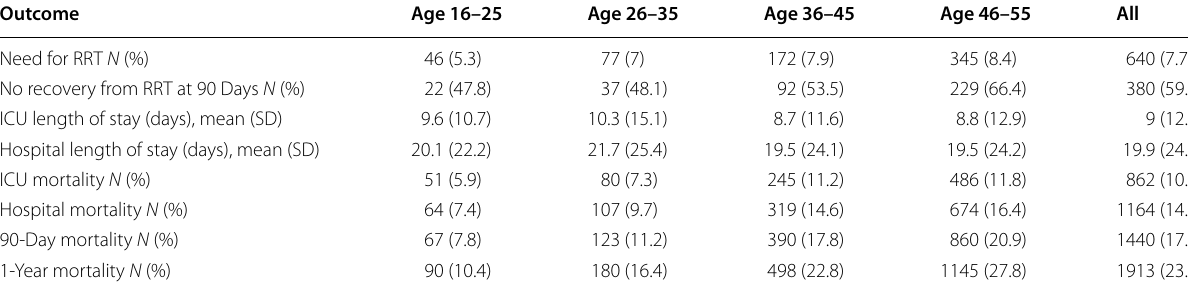
Table 4 Outcomes of patients with acute kidney injury for each of the four age categories (years)